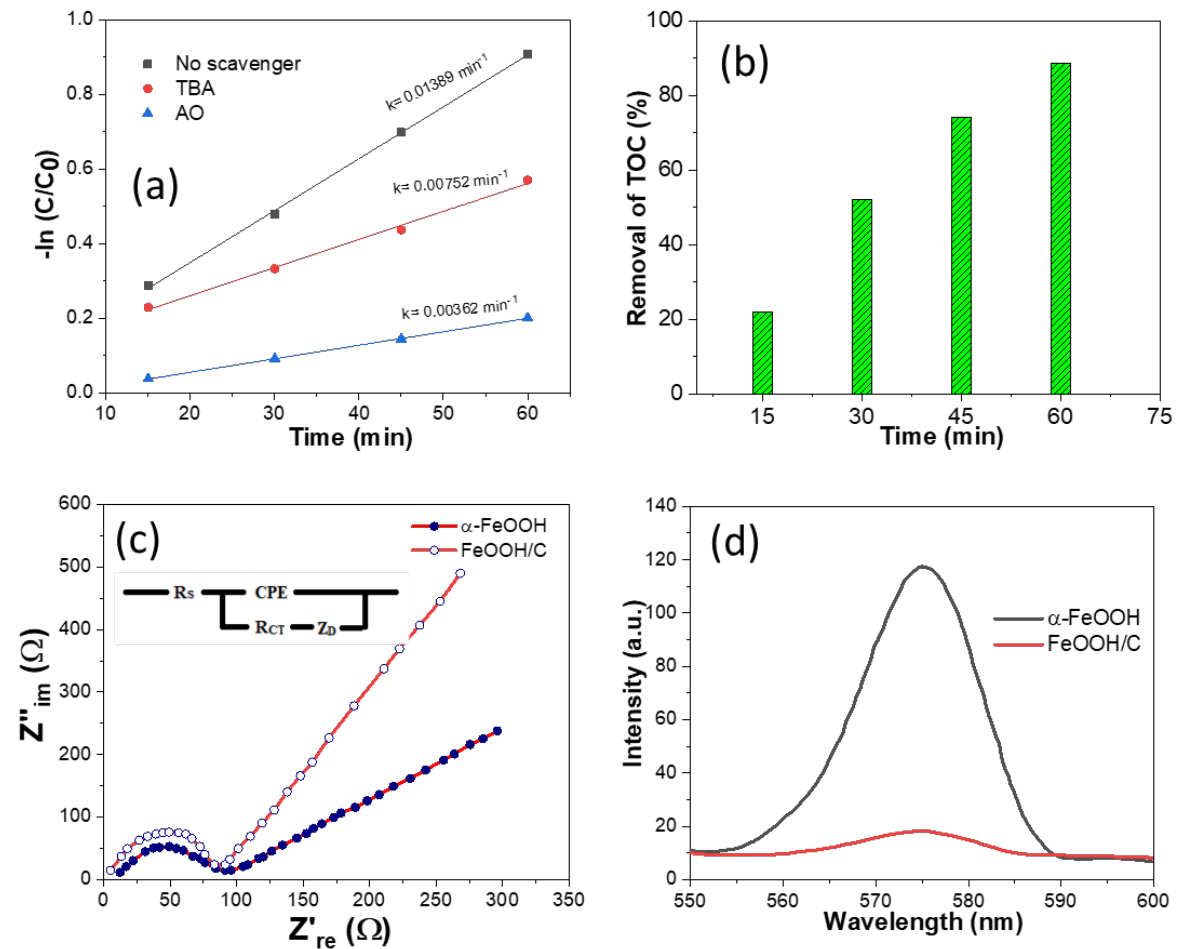
Figure 5. ( a ) Kinetics plot of the FeOOH/C composite in the presence of scavengers, ( b ) removal of total organic content with time using the FeOOH/C composite, ( c ) EIS spectrum and ( d ) PL spectrum of α − FeOOH and the FeOOH/C composite.